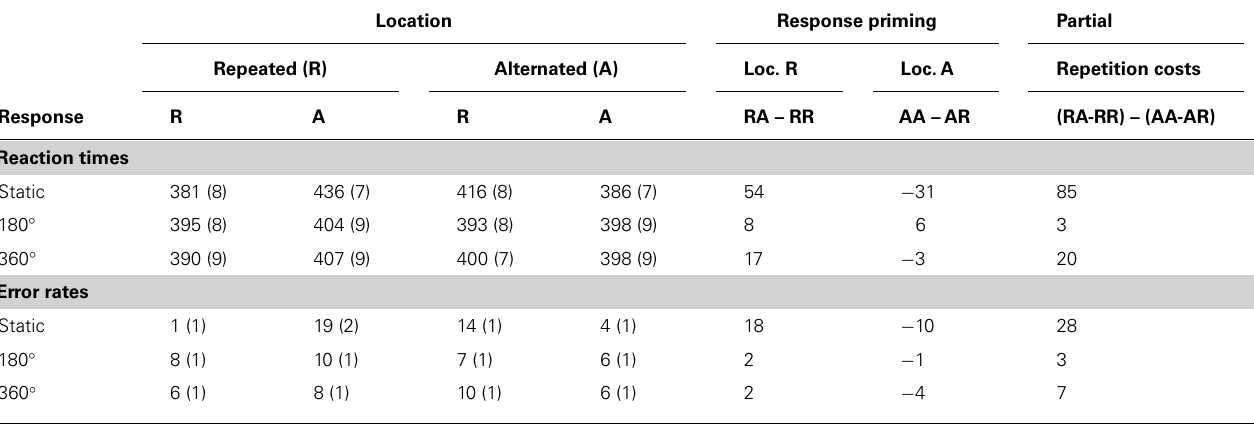
Table 3B | Experiment 3, response-priming and Event-file